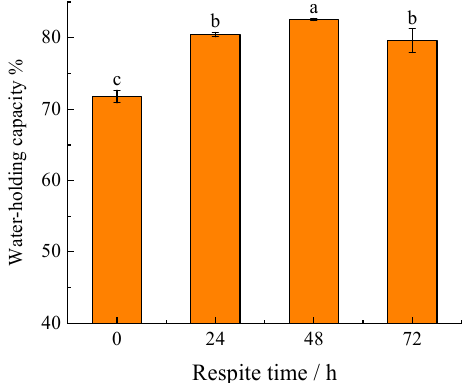
Figure 1. The effect of respite time before live transportation on water-holding capacity of blunt snout bream. Different lowercase letters indicate significant difference ( p < 0.05).